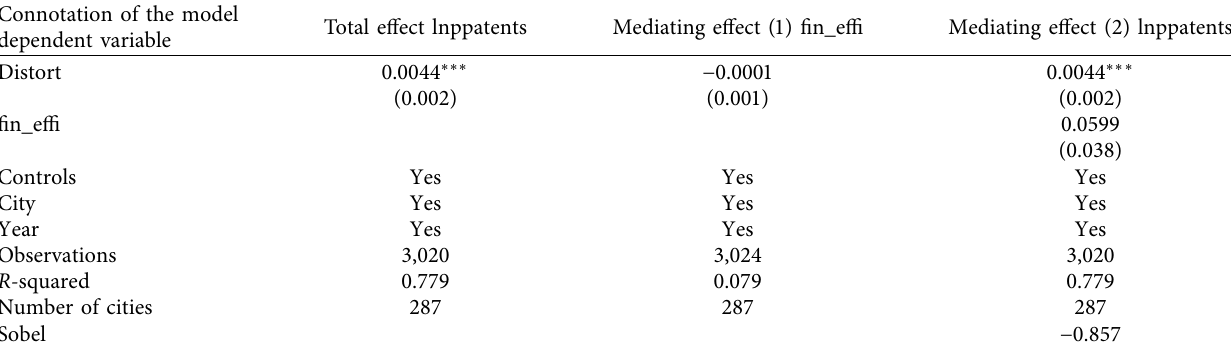
Table 6: Results of financial efficiency mediating effect test.